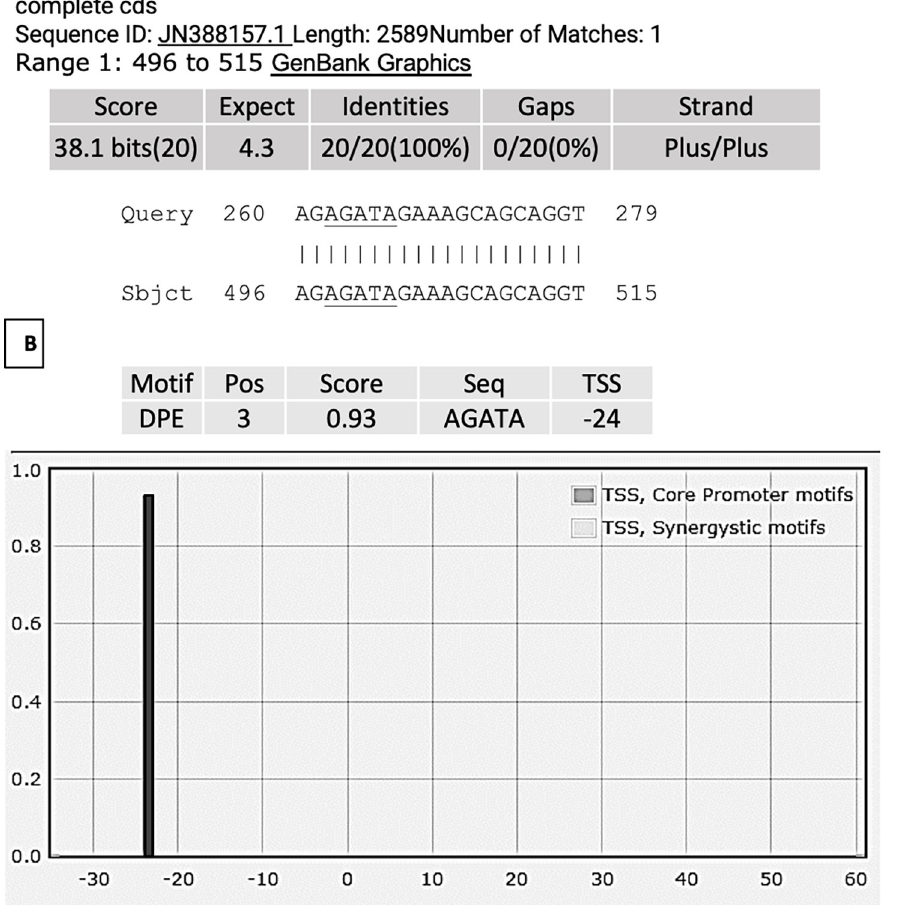
underlined in panel A show motif for a core promoter element DPE, in the HIV-1 sequence, detected by the YAPP tool. Retrovirus inserts in the upstream region may provide promoter